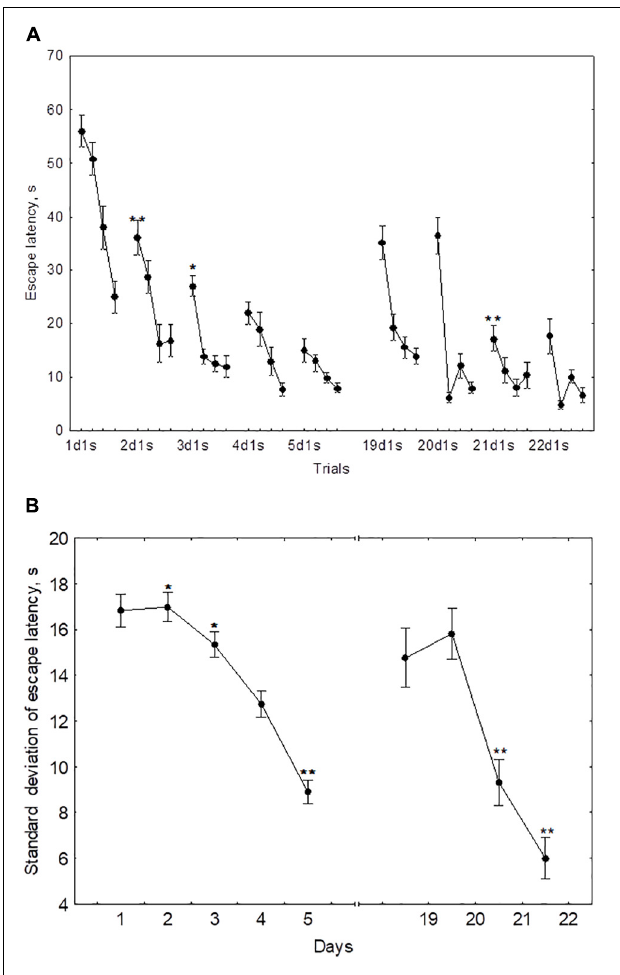
FIGURE 4 | Mean (A) and standard deviation (B) of the escape latency to platform for the initial learning (days 1–5) and reversal learning (days 19–22). * p < 0.05 and ** p < 0.01 relative to the previous day.